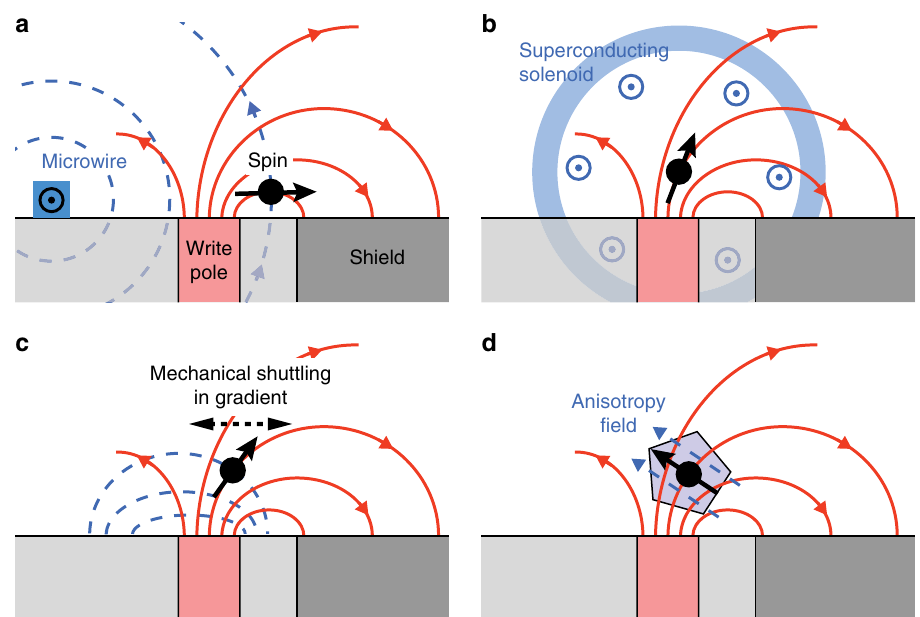
Figure 6 | Proposed arrangements for ultrafast spin manipulation. Write head field is symbolized by solid red field lines and orthogonal auxiliary field is symbolized by dashed blue field lines. ( a ) Auxiliary microwire serving as electromagnet 3,4 . ( b ) Auxiliary macroscopic solenoid. ( c ) An ac field is generated by rapid motion of spin in the pole gradient, for example, with a mechanical resonator 37 or by an electrical field 33,34 . ( d ) Internal anisotropy provides the orthogonal field, such as the crystal field of a nitrogen-vacancy centre 46